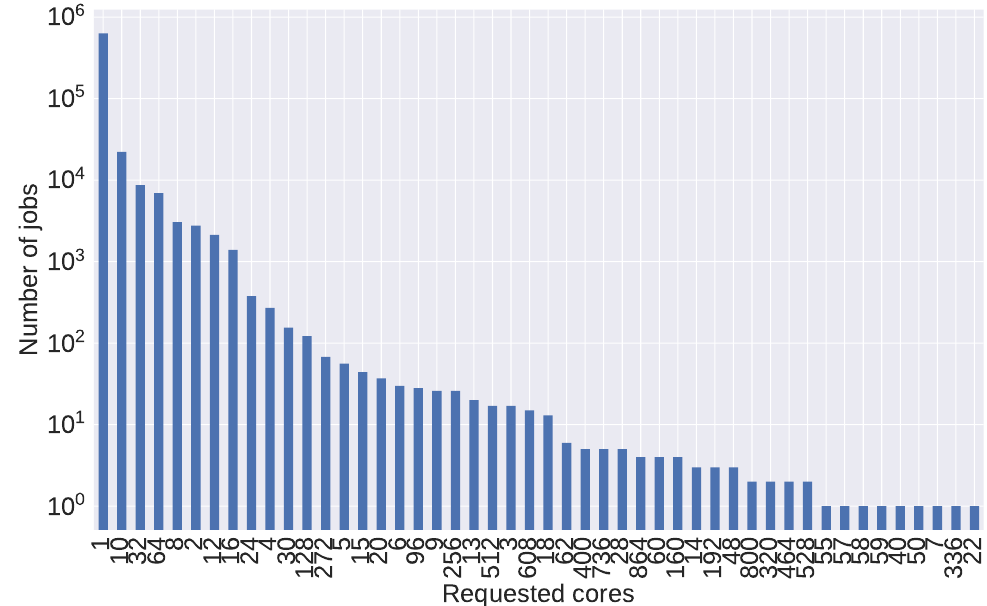
Figure 18. Number of CPU requests during one year in HPC cluster, sorted by the number of cores requested per